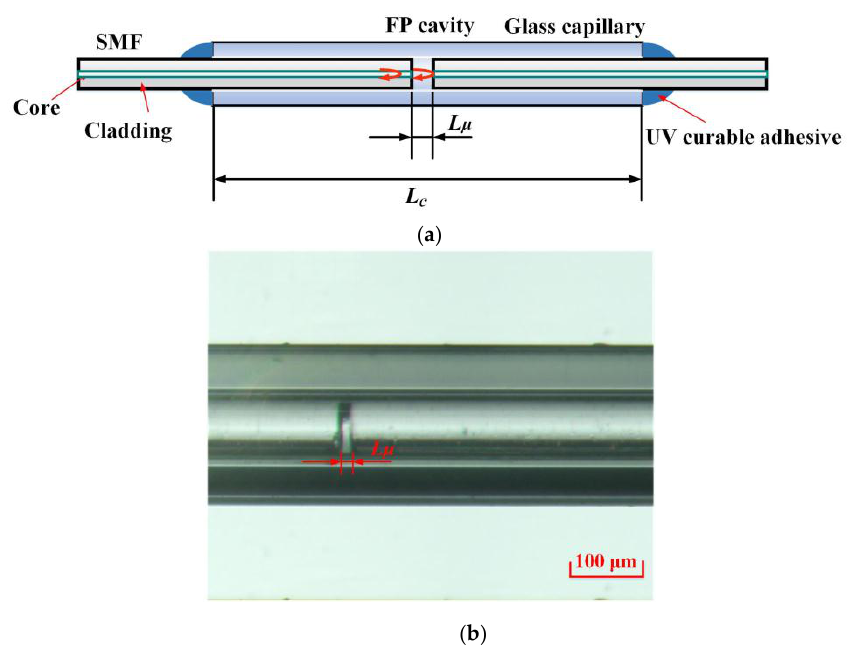
Figure 1. Structure of the extrinsic Fabry–Perot interferometric (EFPI) microcavity fiber-optic strain sensor. The sensor is composed of two vertically cut single mode fibers with a short facet separation in the level of micrometers and a centimeters-long glass capillary. ( a ) Schematic of the sensor, ( b ) microscopic photograph of the microcavity. In which, L µ and L C are the microcavity length and the capillary length, respectively.